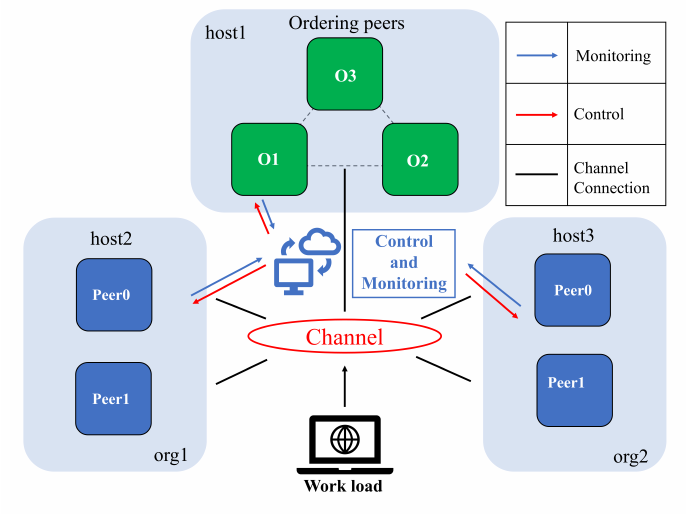
Figure 6. Simulation